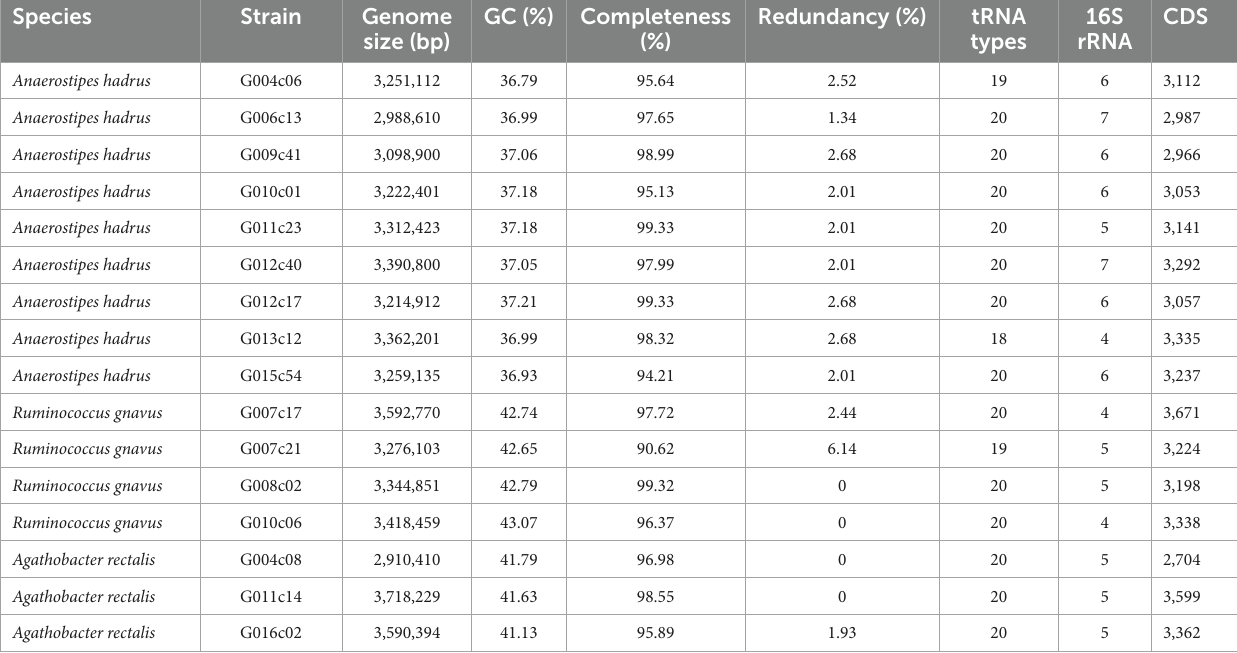
TABLE 1 Circular single-amplified genomes (cSAGs) of A. hadrus , A. rectalis , and R. gnavus. Species Strain Genome size